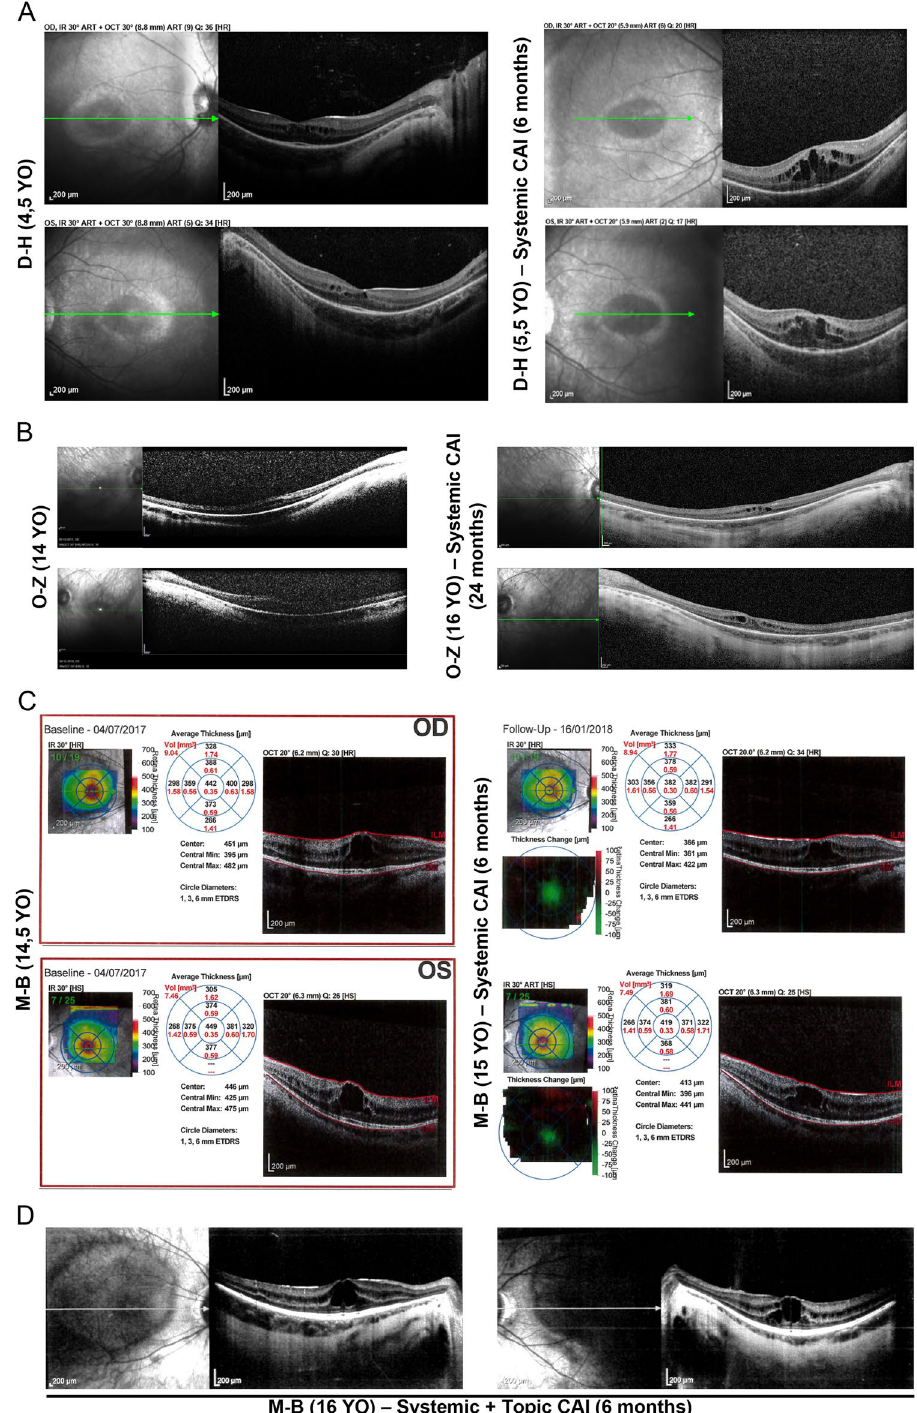
Figure 2. Evolution of CM upon treatment with CAIs monitored by OCT. ( A ) Transfoveal images of patient H–D before (left panels) and after (right panels) 6 months of treatment with acetazolamide. Systemic CA inhibition with acetazolamide did not prevent progression of CM in patient H–D. During the time of treatment, CM volume in transfoveal images progressed by 6-folds on the right eye and 7-folds on the left eye, and the foveal thickness was increased from 289 µm to 503 µm in the right retina and from 278 µm to 456 µm in the left retina. ( B ) Use of acetazolamide in patient O-Z was associated to a stable CM over a 24-month period. ( C ) Transfoveal images of patient M-B before (left panels) and after (right panels) 6 months of treatment with acetazolamide. OCT scans showed a 19% and 24% decrease of cystoid spaces at the fovea of the right and left retina, respectively. A 21% and 9% decrease of the foveal elevation was also measured in the right and left retina, respectively. ( D ) In an attempt to further decrease the volume of CM, acetazolamide was prescribed in combination with topical applications of brinzolamide for an additional 6 months. Follow-up OCT examination showed a return to baseline measures in terms of CM volume as well as foveal